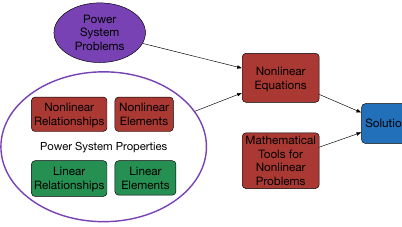
Figure 7. Power system analysis without a proposed technique.